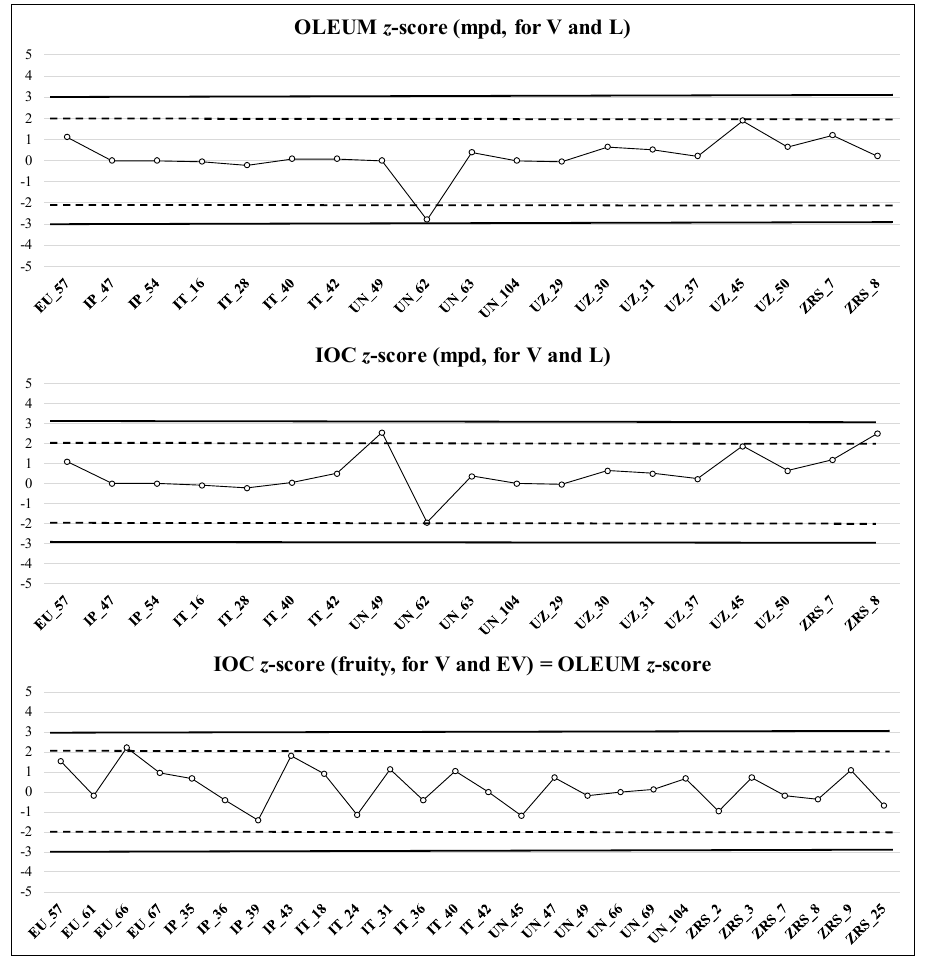
Figure 5. Example of z-score graph for estimation of panel performance, calculated on 38 samples from the third subgroup of the second sampling year (154 samples). Criteria of acceptance: | z | ≤ 2, performance was satisfactory; 2 < | z | ≤ 3, performance was questionable; | z | > 3, performance was considered unsatisfactory. The z-scores were calculated for median of the main perceived defect (for V and L category) and median of fruity attribute (for V and EV category).